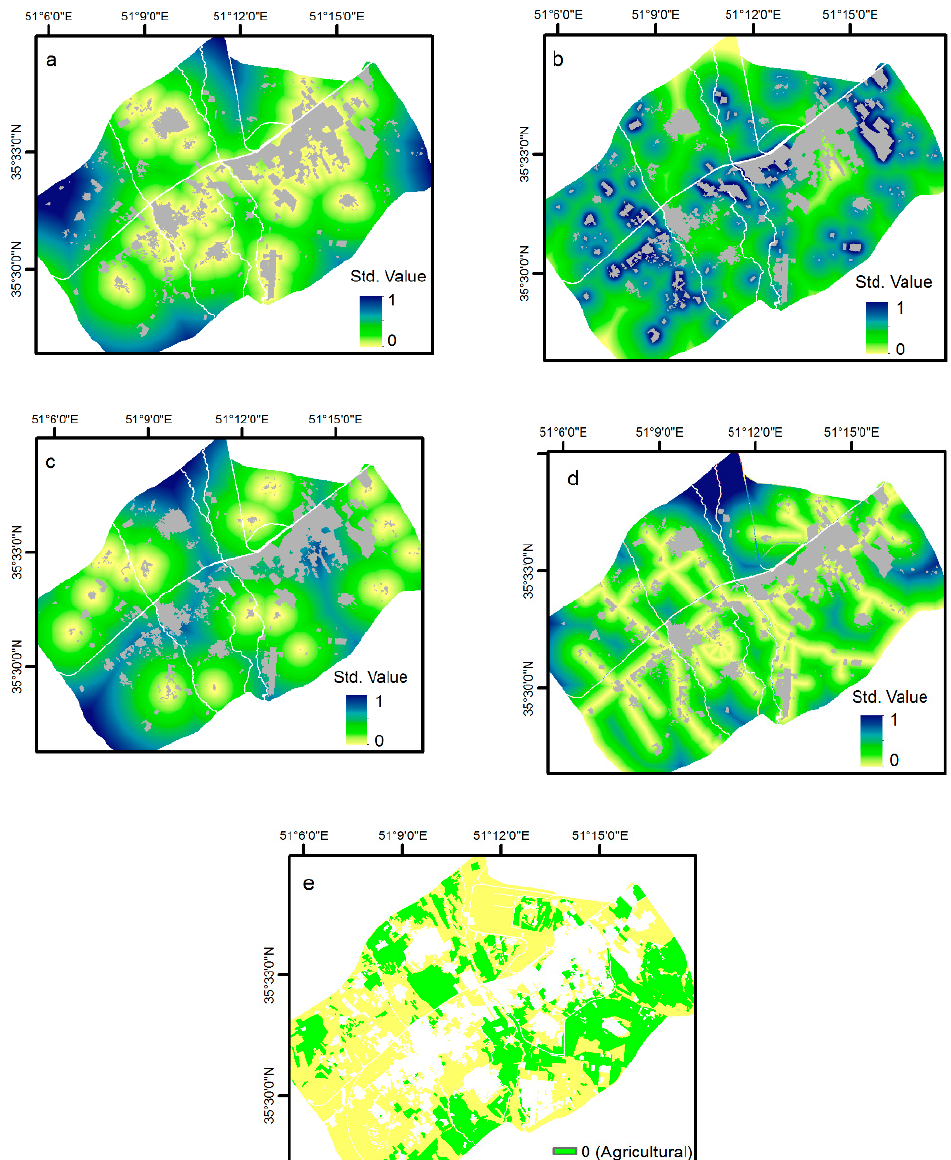
Figure 4. Standardised factors used to predict land use changes: ( a ) distance to urban built-up areas, ( b ) density-distance to industrial land use, ( c ) distance to villages, ( d ) distance to roads, and ( e ) bare land/agricultural land use indicator.